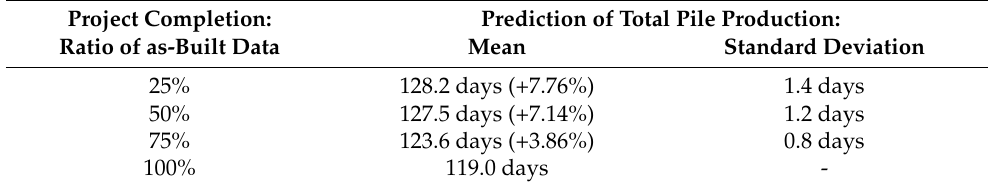
Table 5. Results of simulation study compared to actual duration of pile